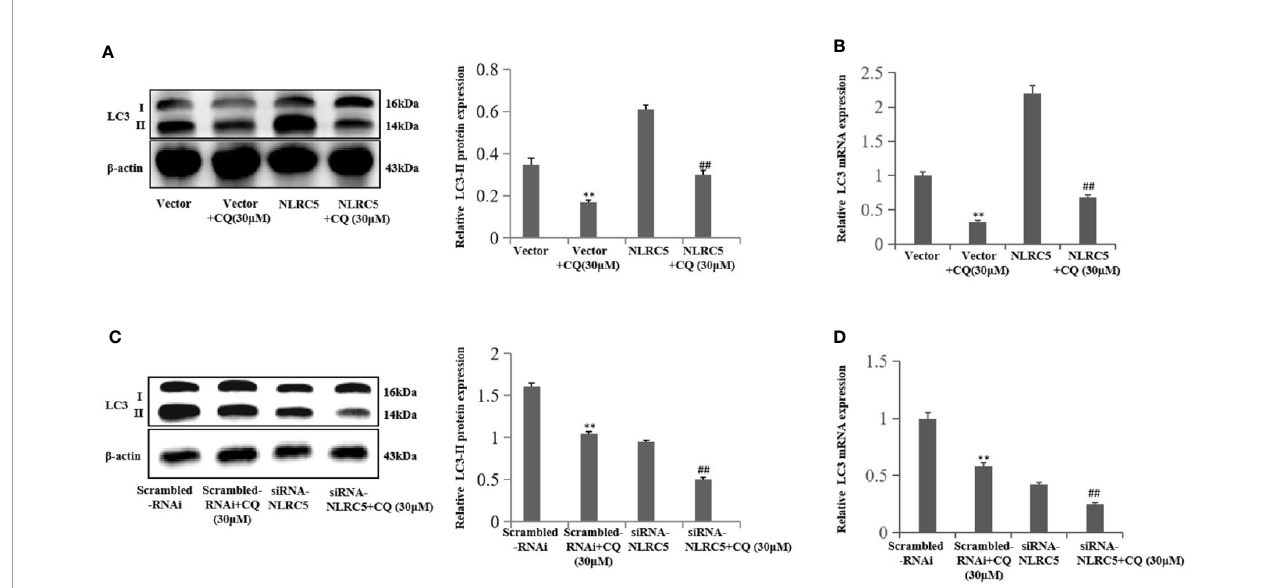
FIGURE 4 | CQ decreases the role of NLRC5 in autophagy (n = 5). (A , B) Representative western blotting and qRT-PCR results showing treatment with 30 m M autophagy inhibitor CQ restricted the level of LC3-II in NLRC5-overexpressed EESCs compared with NLRC5 plasmid group (**P < 0.01 vs. vector group and ## P < 0.01 vs. NLRC5 group). (C , D) Representative western blotting and qRT-PCR results showing treatment with 30 m M autophagy inhibitor CQ inhibited the level of LC3-II in NLRC5-down-regulated EESCs compared with siRNA-NLRC5 group (**P < 0.01 vs. scrambled-RNAi group and ## P < 0.01 vs. siRNA-NLRC5 group).The expression levels of mRNA were normalized with respect to b -actin and were calculated using the 2 - DD Ct method. The protein expression levels were quanti fi ed by Image J software and normalized to b -actin protein levels. The results are represented as the mean ± SEM from at least three independent